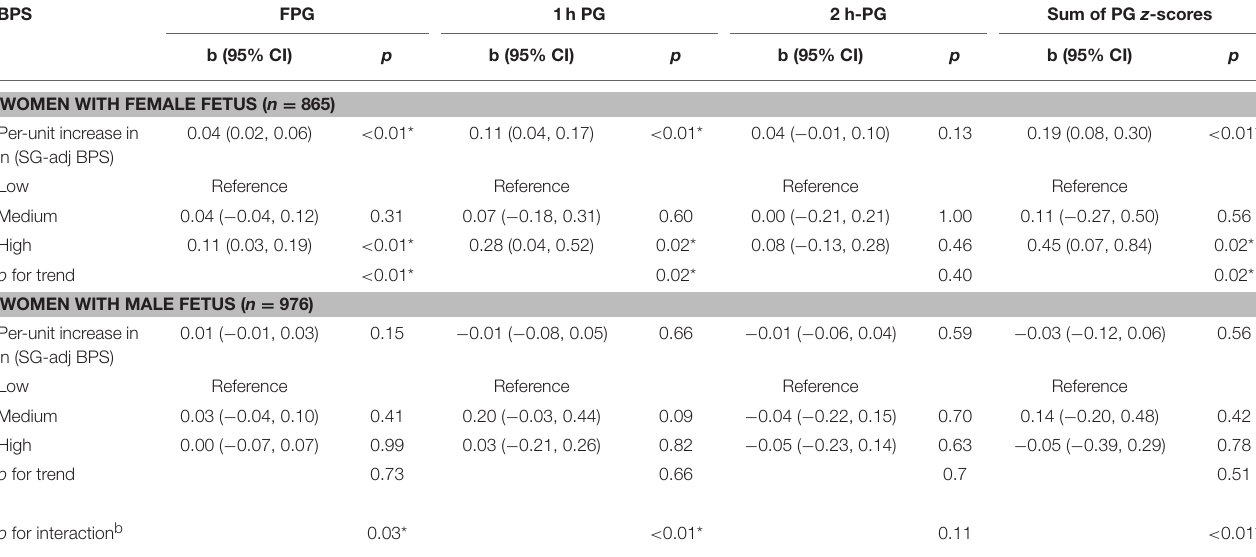
TABLE 5 | Associations of BPS concentrations with glucose levels, stratified by fetal sex a .